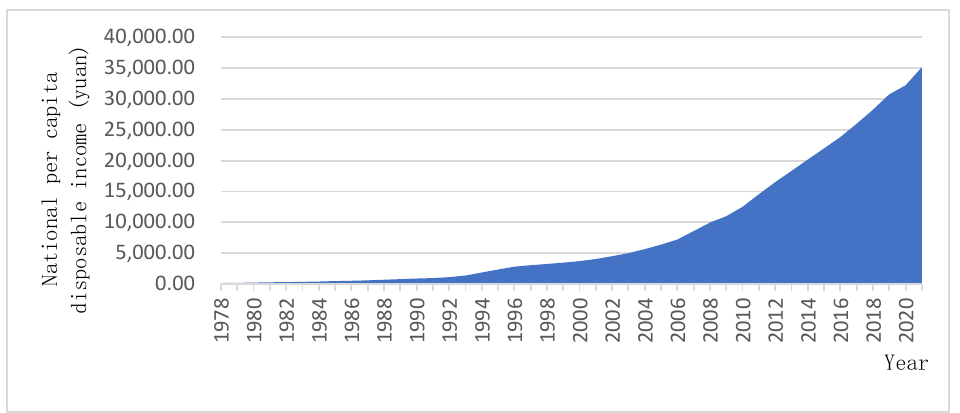
Figure 2. National per capita disposable income since 1978. (Source: Compiled from relevant data published by the National Bureau of Statistics of China in previous years).